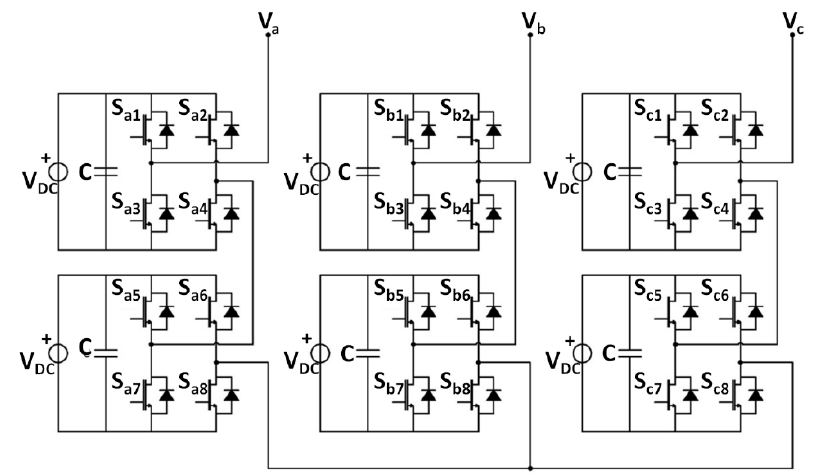
Figure 1. Three-phase, five-level structure of a CHBMI.